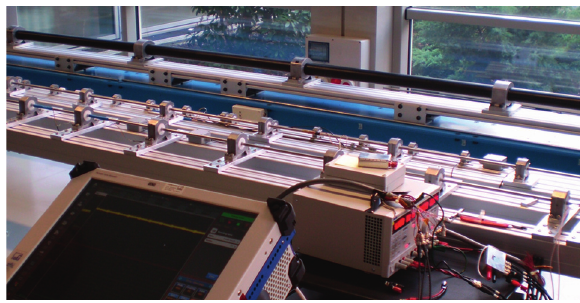
Figure 12: Hopkinson bar test-bench at Politecnico di Torino.